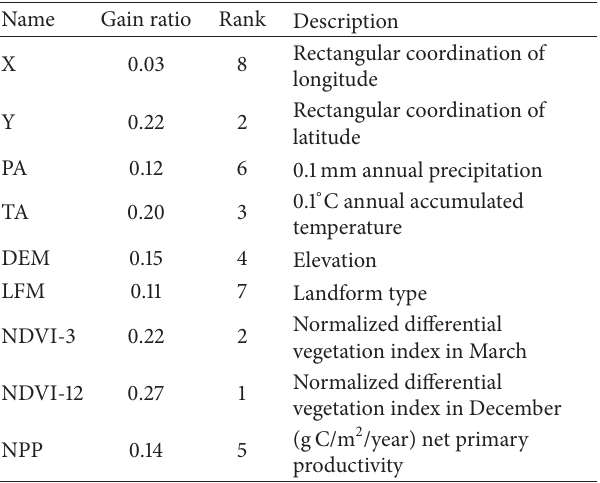
Table 3: The attributegain ratio value for constructing decision tree.